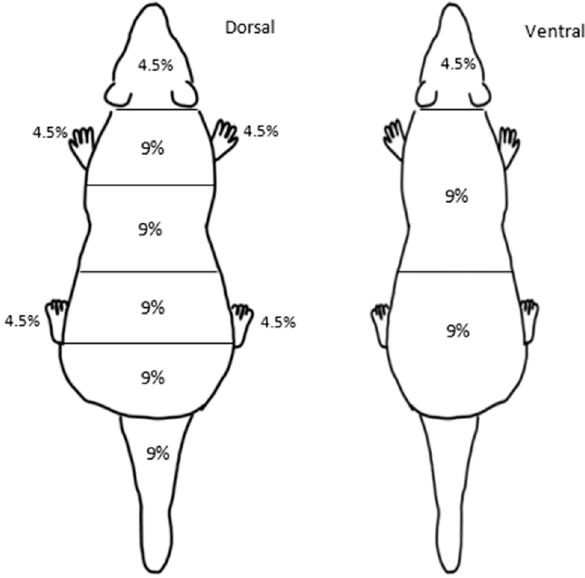
Figure 5. The ‘Rule of Nines’ schematically depicted for C. obscurus . The ‘Rule of Nines’ can be used to calculate a rough percentage of hair loss to support welfare